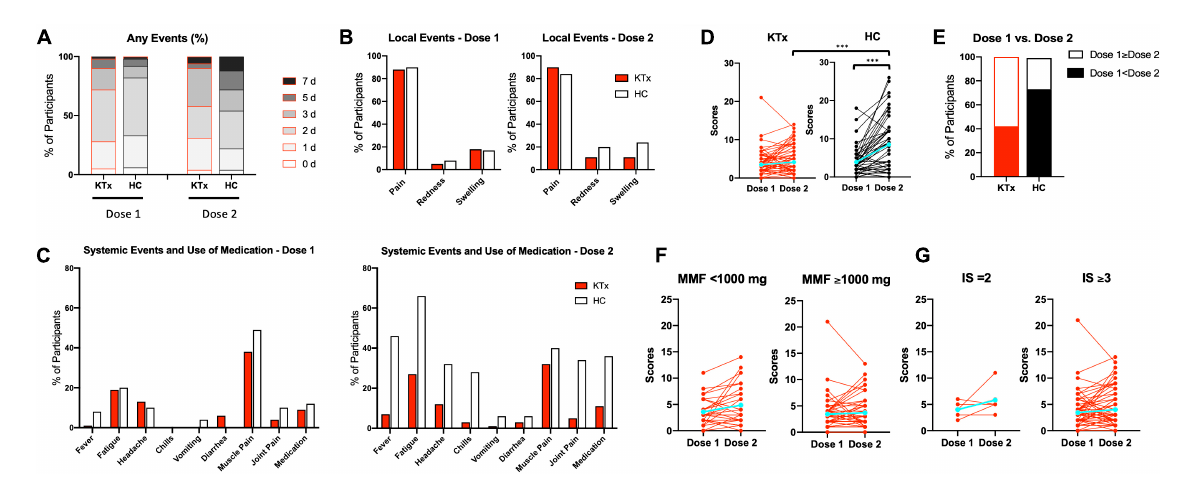
FIGURE1 Local and systemic adverse reactions after each vaccination, as recorded by KTx recipients and HCs. (A) Comparison how many days KTx recipients and HCs suffered from any local or systemic adverse events after D1 and D2 vaccination. Day 0 is the day of vaccination. (B,C) Incidence of local (B) and systemic (C) adverse events. (D) Comparison of ‘Yes’ or ‘No’ scores and change in groups. (E) Percentage of scores D1 < D2 or D1 ≥ D2 in each group. (F,G) Comparison of scores and change with regard to MMF dose (F) and number of immunosuppressive drugs (G) in KTx recipients. Blue lines represent means. Data were analyzed using the Mann-Whitney U test (*** P <